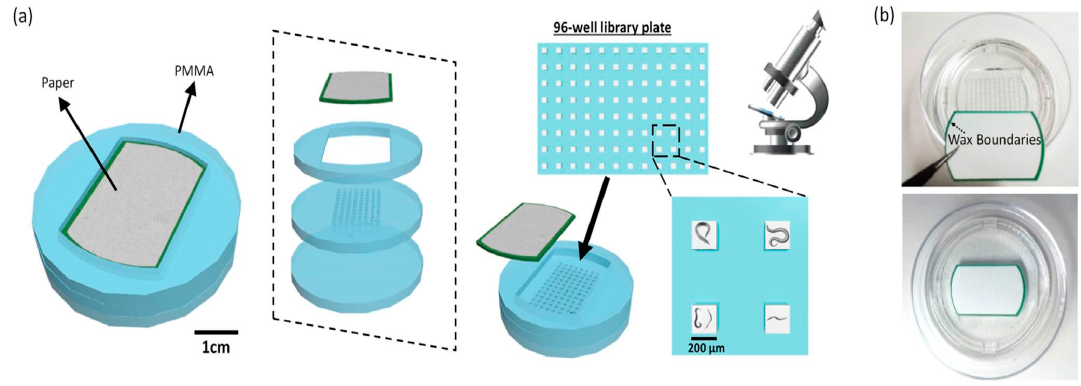
Figure 1. ( a ) Schematic diagrams and ( b ) photos of the proposed paper-based culture platform for C. elegans studies.